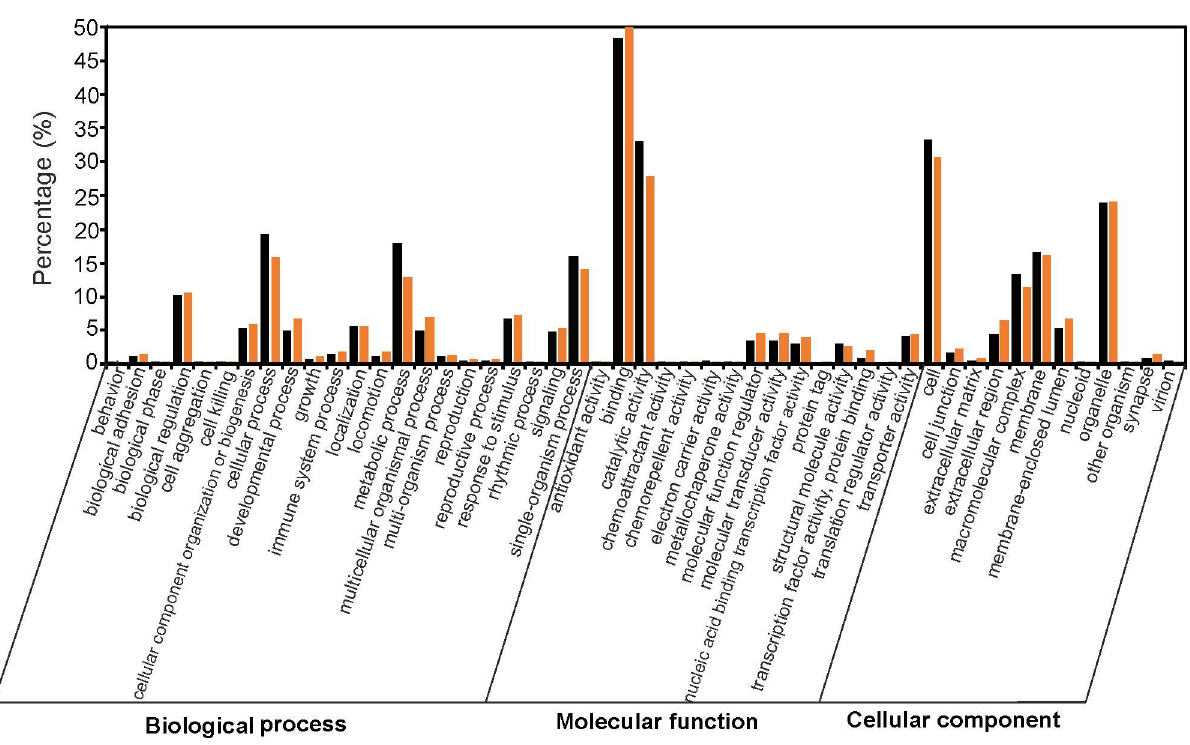
Fig 2. Gene Ontology comparative classification of the sea trout skin transcriptome (black) and multi-tissue transcriptome from the River Hayle and River Teign in southwest England (orange).